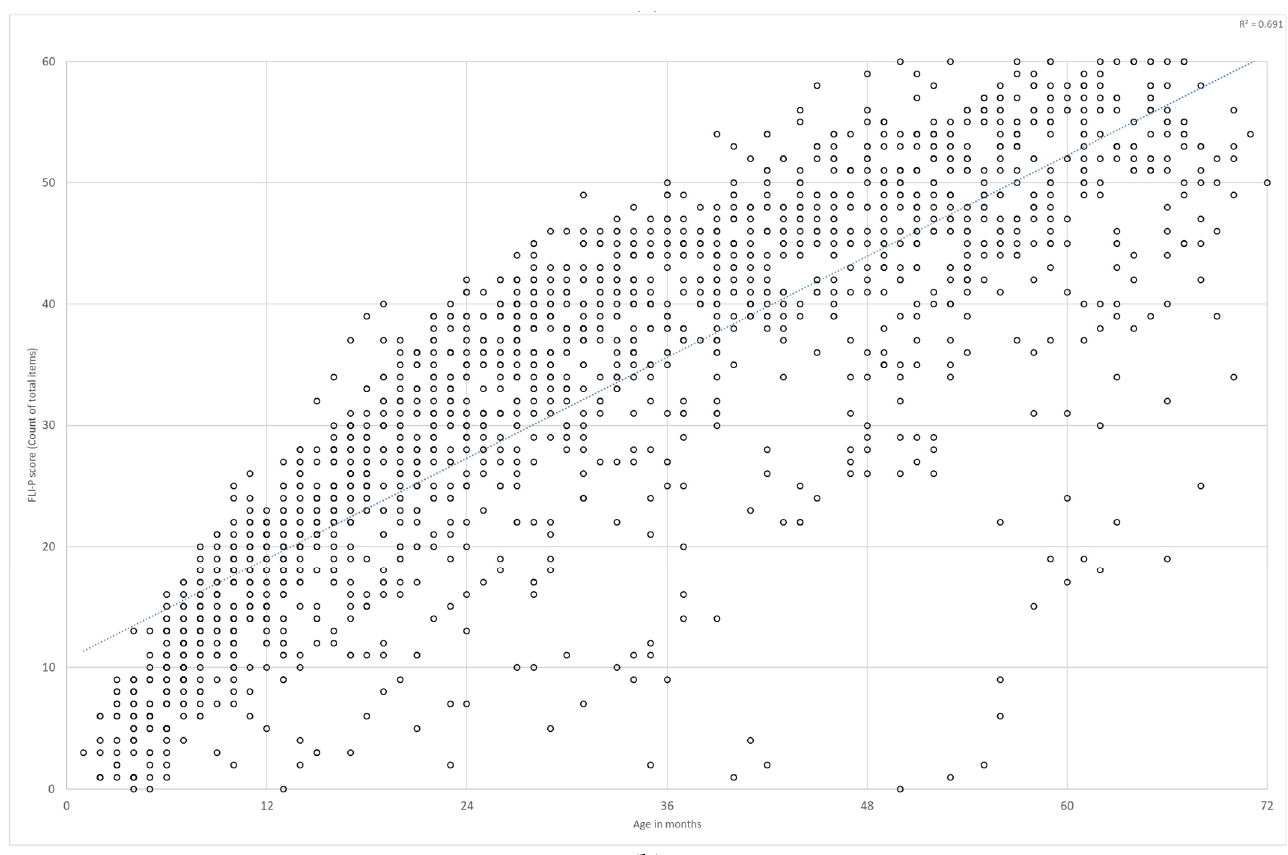
Figure 7. FLI-P scores of children with ( a ) unilateral HL and ( b ) bilateral